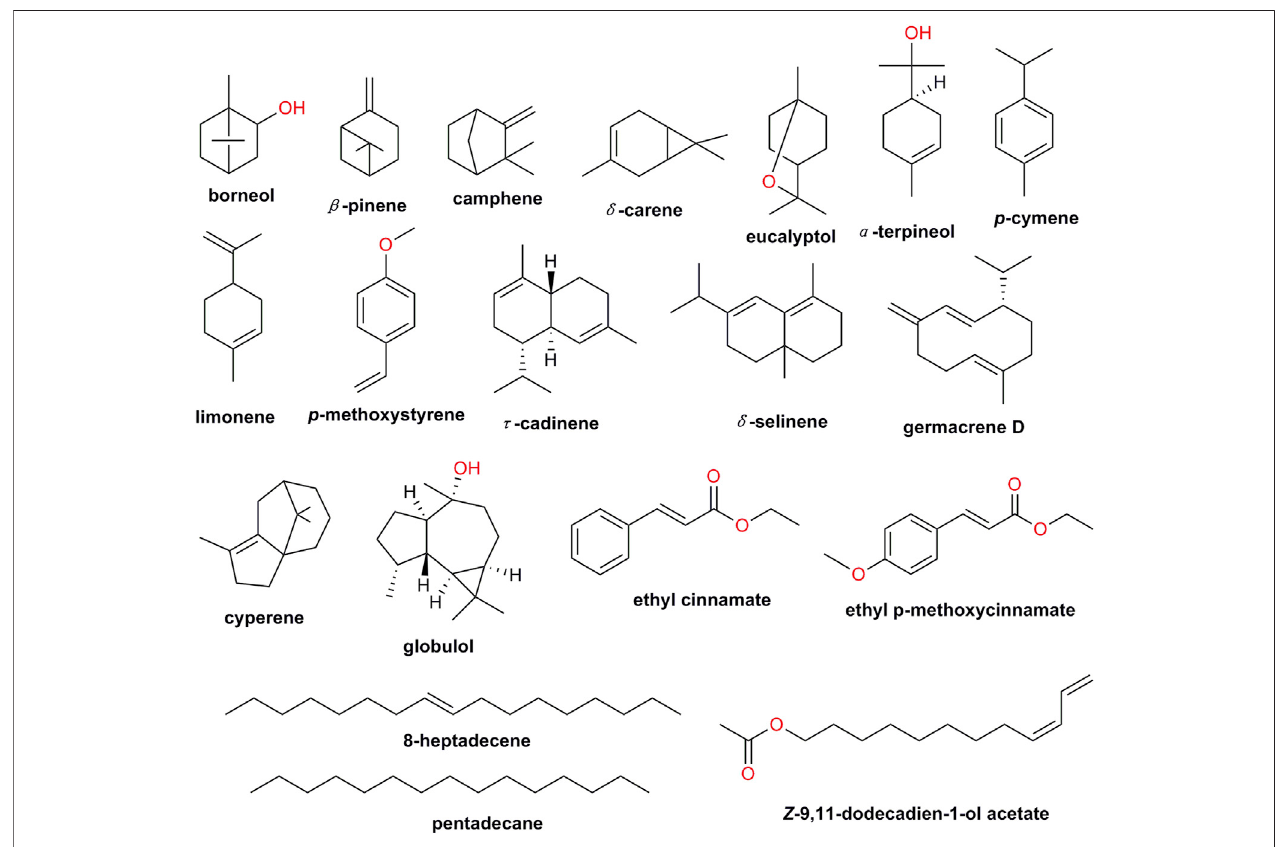
FIGURE 2 | Chemical structures of main volatile components in K. galanga